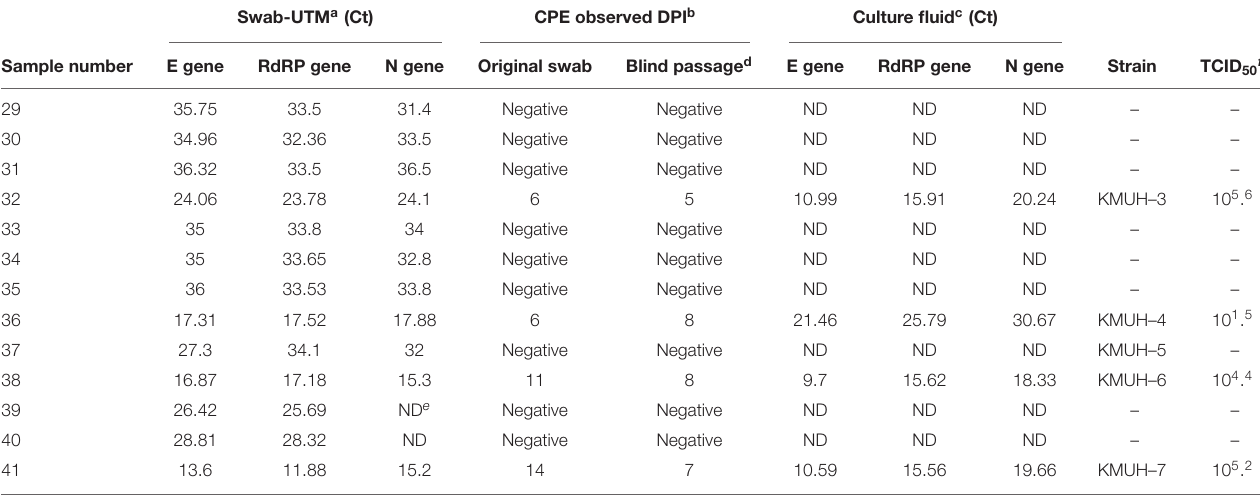
TABLE 1 | Detection of the presence of SARS-CoV-2 using qRT-PCR and VERO E6 cell CPE. Swab-UTM a (Ct) CPE observed DPI b Culture fluid c